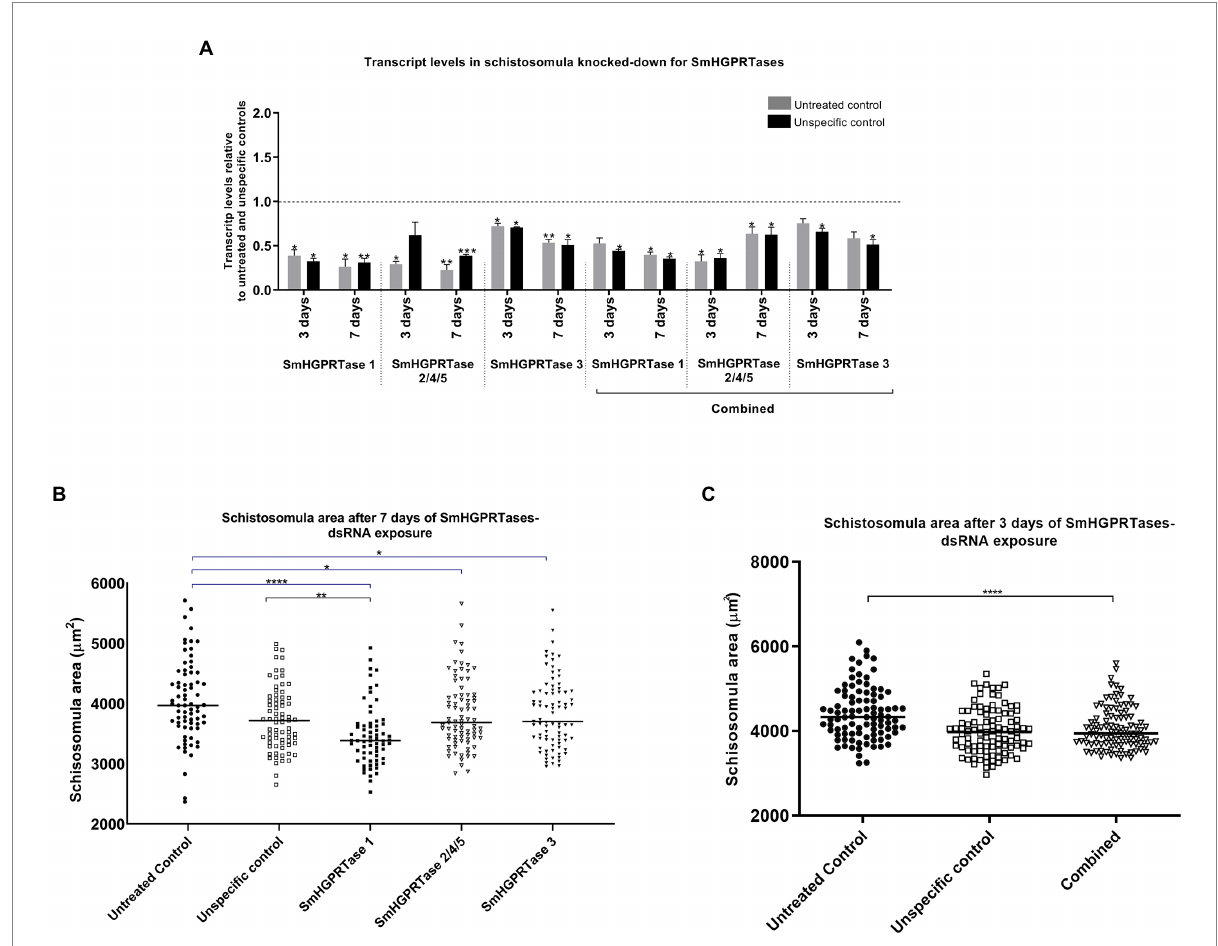
FIGURE 7 SmHGPRTases transcript levels and area of schistosomula after exposure to dsRNAs. (A) Bars representing the transcript levels of SmHGPRTase 1, SmHGPRTase 2/4/5, and SmHGPRTase 3 in schistosomula after exposure to the specific dsRNAs separately or in combination (combined) relative to the untreated (gray) or unspecific control (black) after 3 and 7 days. Above the bars are represented the standard error of the mean of three replicates. After verifying the normality using the Shapiro–Wilk test, significant differences compared to control conditions were analyzed by unpaired t -test. (B) Area ( μ m 2 ) of schistosomula exposed to the SmHGPRTases-dsRNAs after 7 days. Symbols represent a single parasite for each experimental group. Black circles, untread control; White squares, unspecific control; Black square, parasites treated with SmHGPRTase 1 -dsRNA; White triangles, parasites treated with SmHGPRTase 2/4/5-dsRNA ; Black triangles, parasites treated with SmHGPRTase 3 -dsRNA. (C) Area ( μ m 2 ) of schistosomula exposed to the combined group after 3 days. Symbols represent a single parasite for each experimental group. Black circles, untread control; White squares, unspecific control; White triangles, combined group. The horizontal black lines represent the median area of the sample population. After verifying the normality using the D’Agostino-Pearson test, significant differences compared to control conditions were analyzed by unpaired t -test (* p ≤ 0.05; ** p ≤ 0.01; *** p ≤ 0.001; **** p <